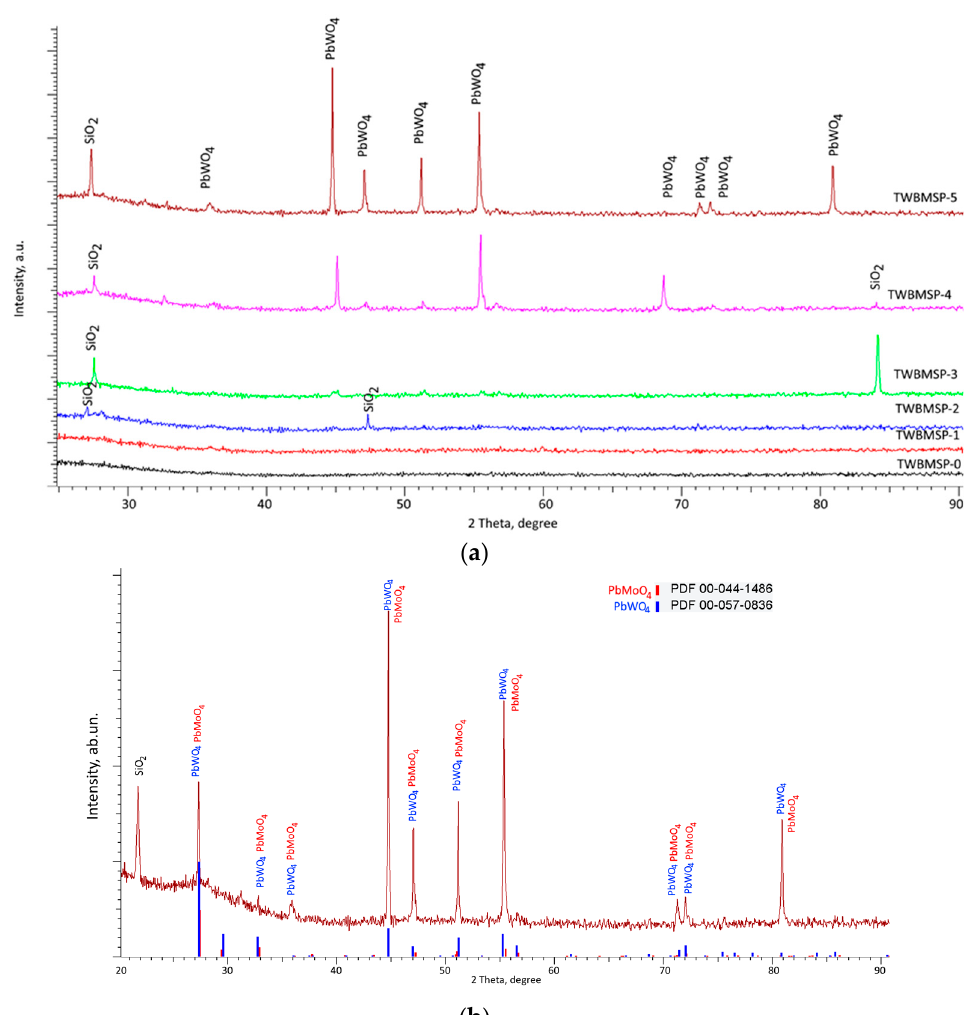
Figure 5. ( a ) X-ray di ff raction pa tt erns of the studied samples as a function of the PbO dopant concentration; ( b ) The results of X-ray di ff raction of the TWBMSP-5 sample, for which the presence of di ff raction re fl ections for the PbWO 4 and PbMoO 4 phases was observed.